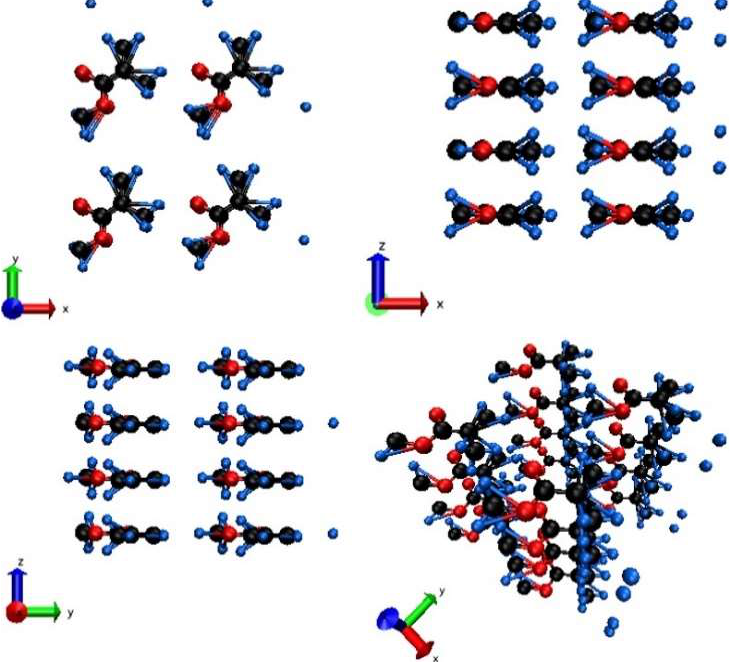
Figure 1. Initial atomic structure of PMMA in the supercell: top view along Z ( top left ), side view along Y ( top right ), side view along X ( bottom left ), perspective view ( bottom right ). Black balls are C, red balls are O, and blue balls are H atoms.